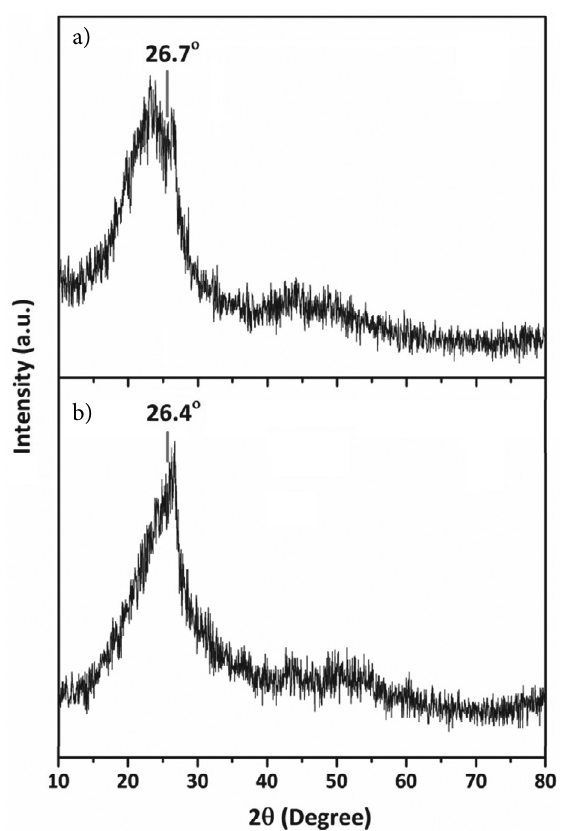
Figure 3. IR spectra of (a) pristine GO/PAMAM, (b) GO/PAMAM modified at pH = 0 and ARS–adsorbed GO/PAMAM at (c) pH = 0, Figure 2. XRD spectra of (a) pristine GO/PAMAM, (b) GO/PAMAM (d) pH = 2, (e) pH = 5 and (f) pH = modified at pH = 0. Rafi et al.: GO/PAMAM as a High Capacity Adsorbent for Removal ...